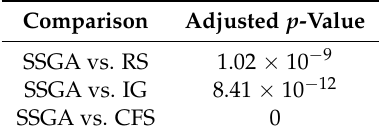
Table 5. Post hoc comparison of the results in terms of